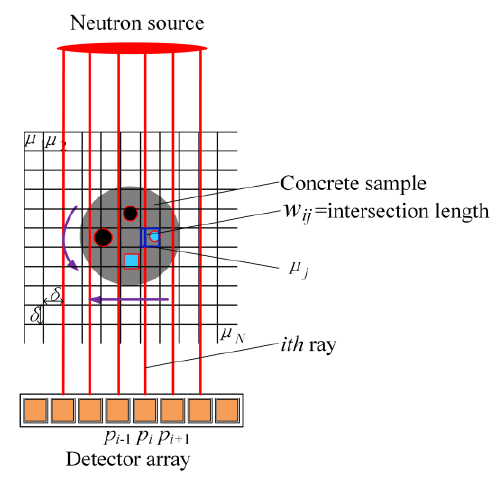
Fig. 4. System matrix calculation model